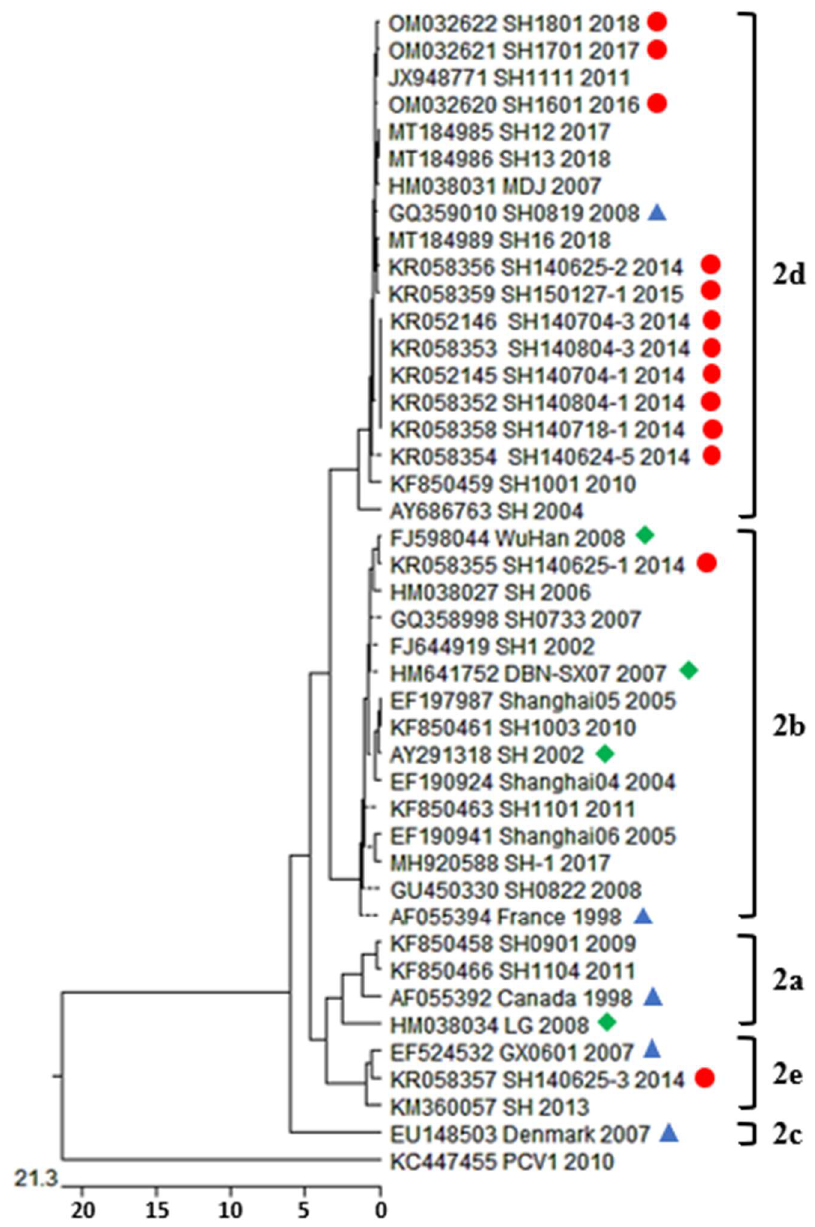
Figure 3. Phylogenetic analysis: phylogenetic tree was constructed by neighbor-joining (NJ) method for newly isolated 13 ORF2 sequences of PCV2 using MEGA5.0 software. Bootstrap values were calculated on 1000 replicates. The reference sequences of PCV2 clades are indicated with blue diamonds. The new PCV2 isolates identified in this study are labeled with red circles and PCV2 available vaccine strains are indicated with green triangles.